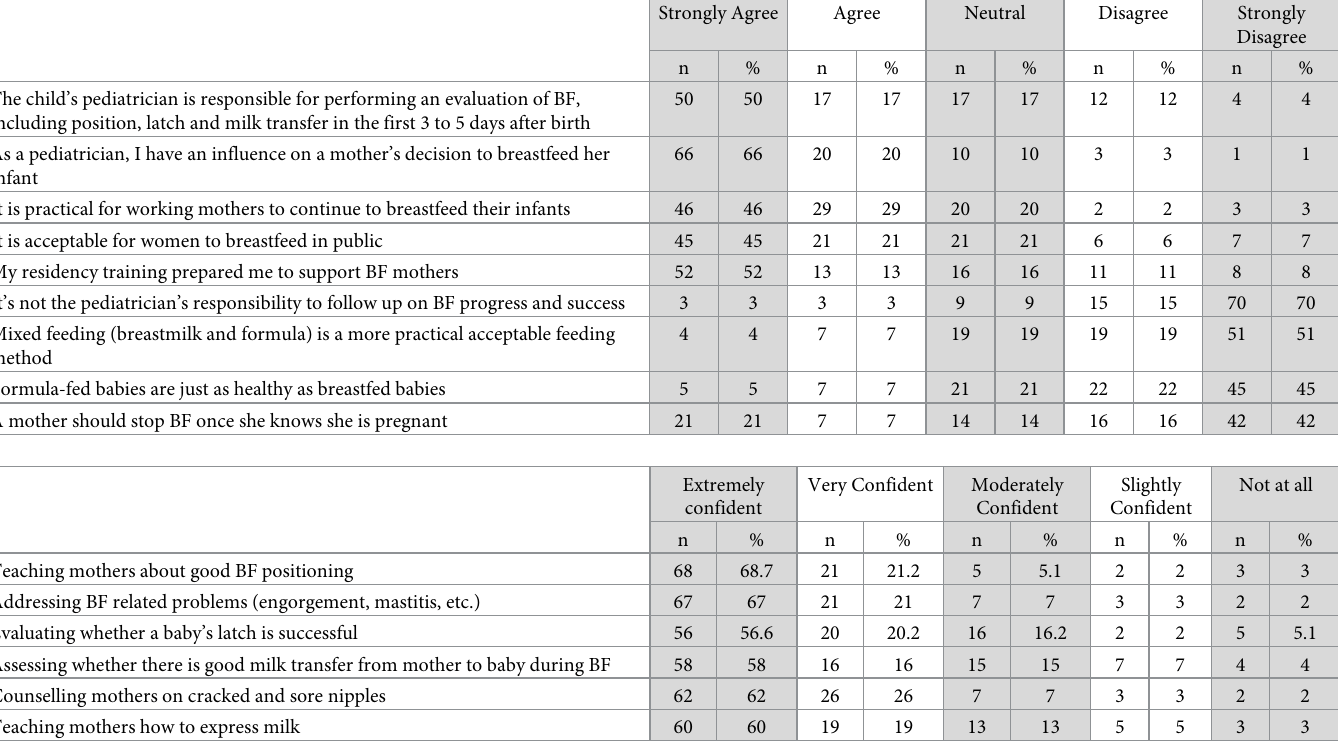
Table 3. a. Attitudes towards BF among study participants. b. Self-assessment of pediatricians’ confidence/ comfort in addressing and managing BF-related problems. Strongly Agree Agree Neutral Disagree Strongly Disagree